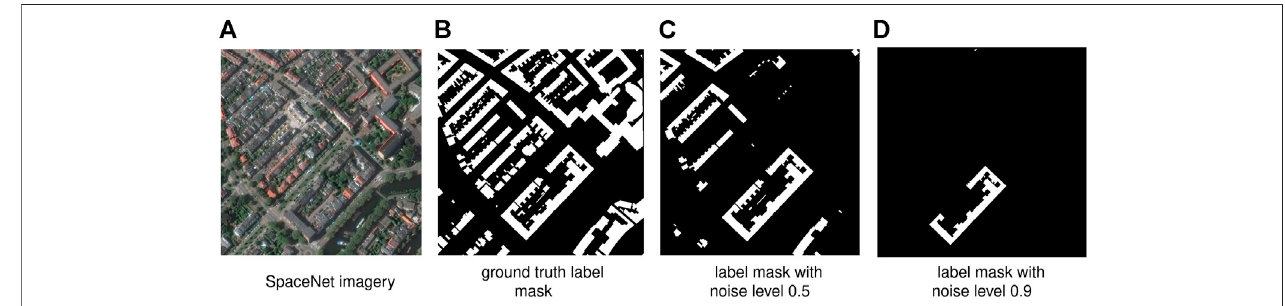
FIGURE 1 | A sample of the imagery and labels used in our experiments. (A) SpaceNet imagery. (B) Ground truth label mask. (C) Label mask with noise level 0.5. (D) Label mask with noise level 0.9.